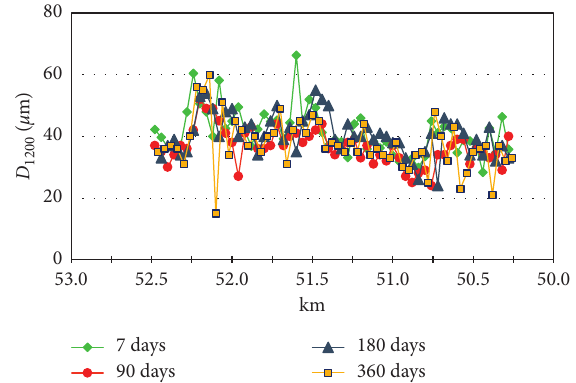
Figure 11: Deflections D 1200 measured with FWD after 7, 90, 180, and 360 days of the construction.